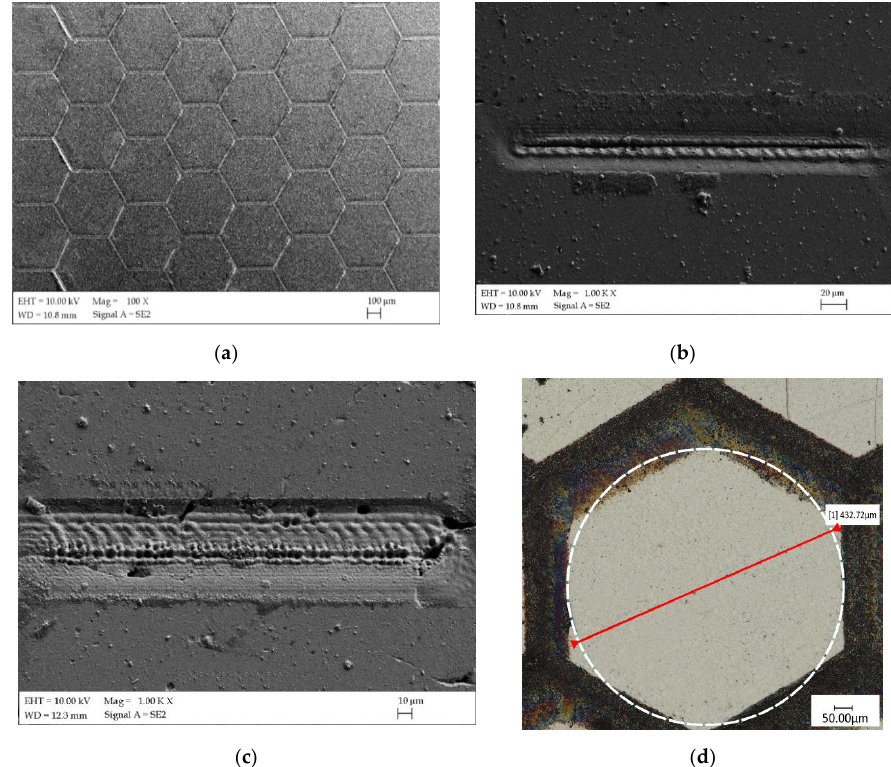
Figure 4. Examples of surface topography of the samples after texturing ( a ) SEM image M4; ( b ) SEM image single track M4; ( c ) SEM image single track M4; ( d ) optical microscopy M4.